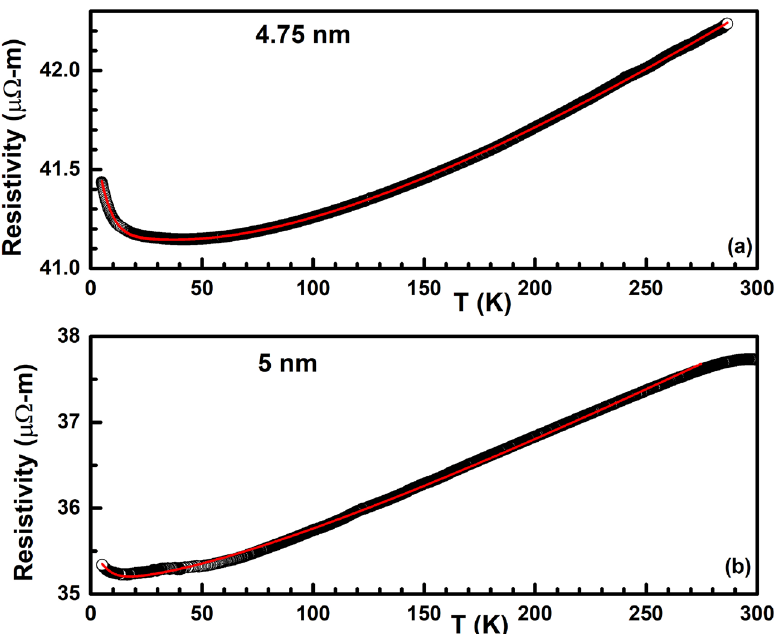
Figure 6. Temperature variation of resistivity of the ( a ) 5 nm and ( b ) 4.75 nm thin film. Black open circles denote the experimentally obtained data points while the red curve is a fit to Eq. (6) (see text for